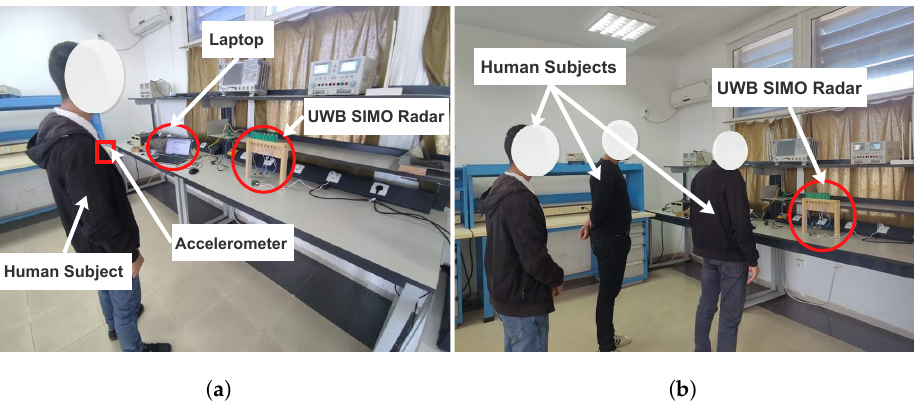
Figure 4. Human subject experiment setup: The persons are exposed to the radar at different positions, in which the accelerometer is attached to the chest in order to serve as a reference signal. ( a ) For one person. ( b ) For multiple